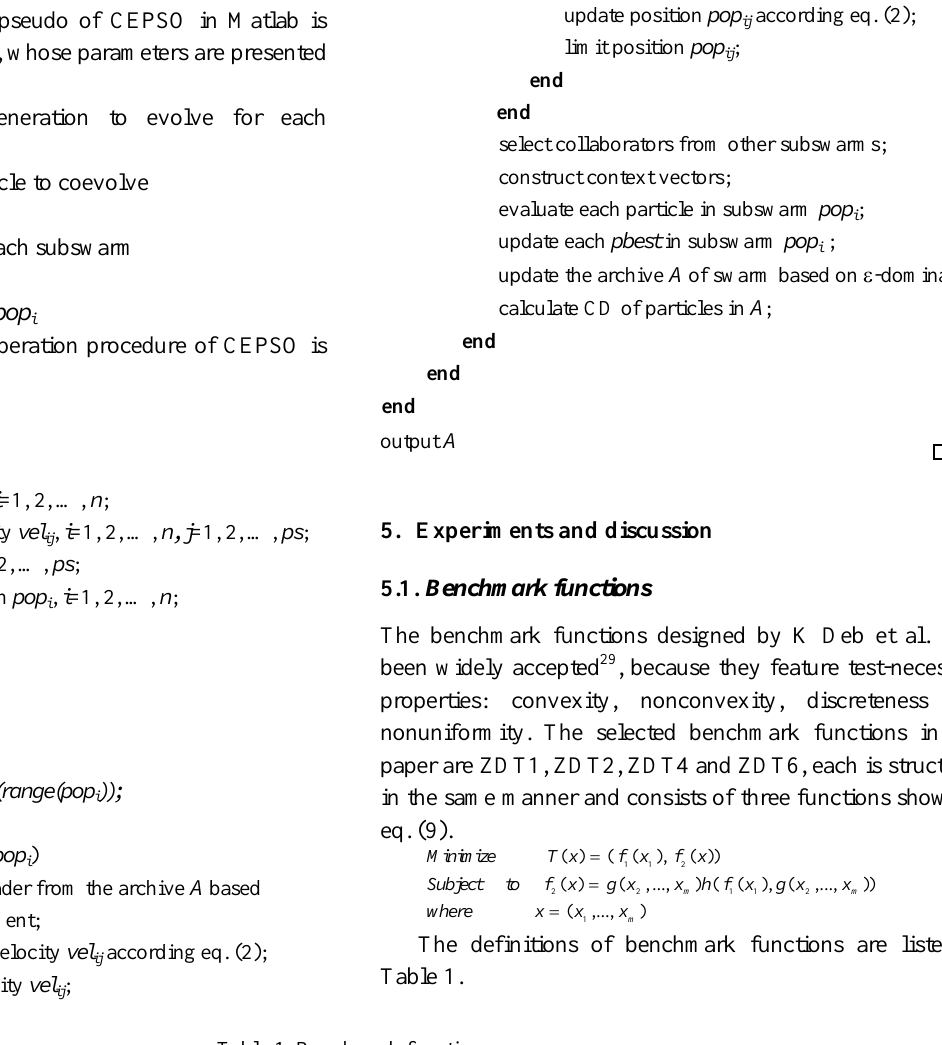
calculate velocity vel ij according eq. (2);